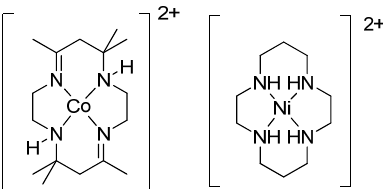
Figure 5. N - rac -CoHMD 2+ (left) and Ni(II)-cyclam (right)